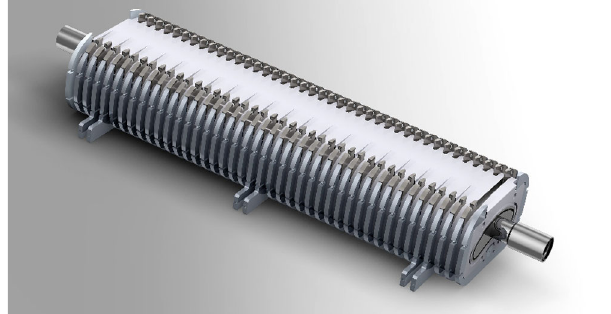
FIG. 2. SCU0 undulator magnet core.